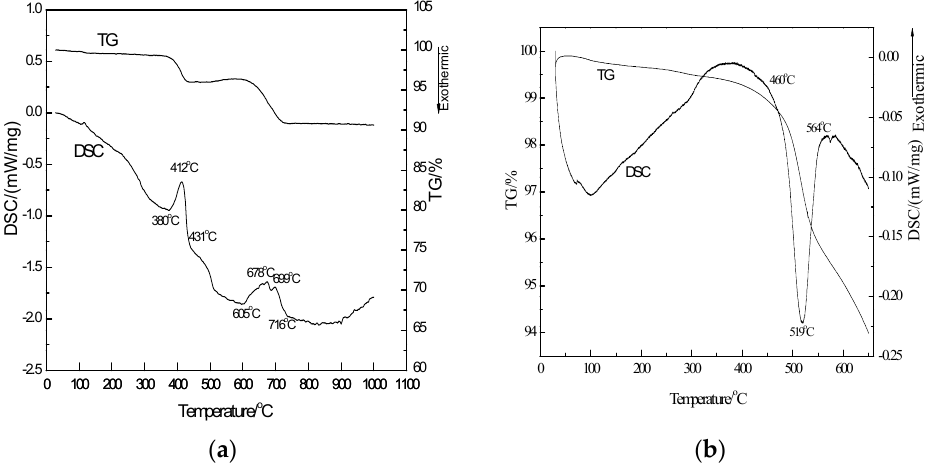
Figure 2. TG-DSC curves of the roasting process at a heating rate of 10 °C min − 1 ( a ) magnetic tailing mixed with CaO and coal ( b ) magnetic tailing.